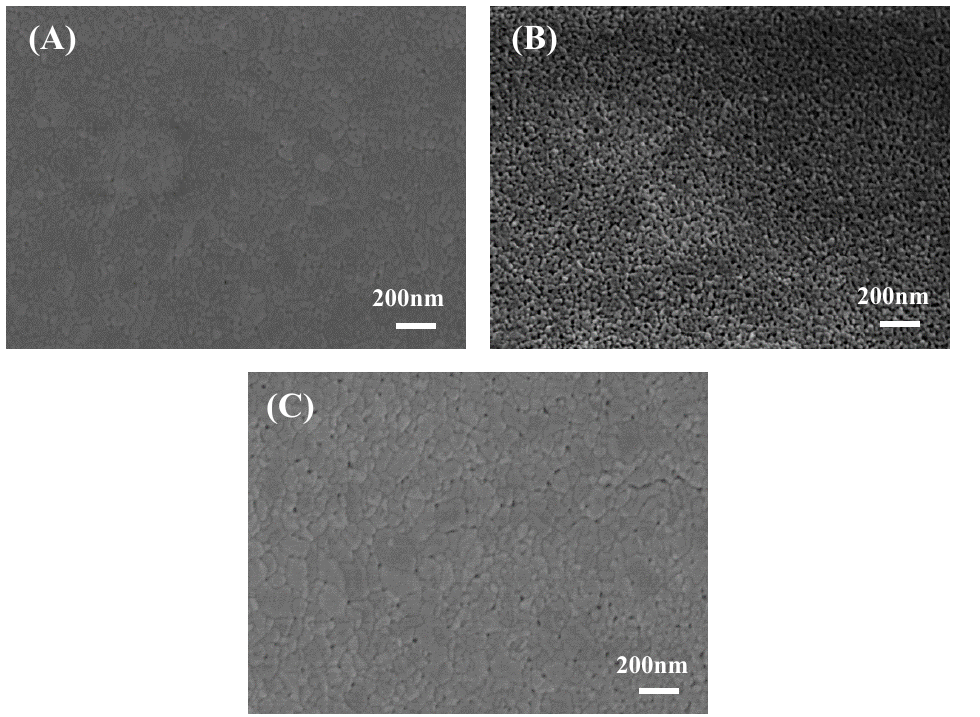
Figure 3. Scanning electron microscopy (SEM) images of different g-C 3 N 4 /TiO 2 thin-film samples: ( A ) 3-layer g-C 3 N 4 (0.5)/TiO 2 ; ( B ) 5-layer g-C 3 N 4 (0.5)/TiO 2 ; ( C ) 7-layer g-C 3 N 4 (0.5)/TiO 2.